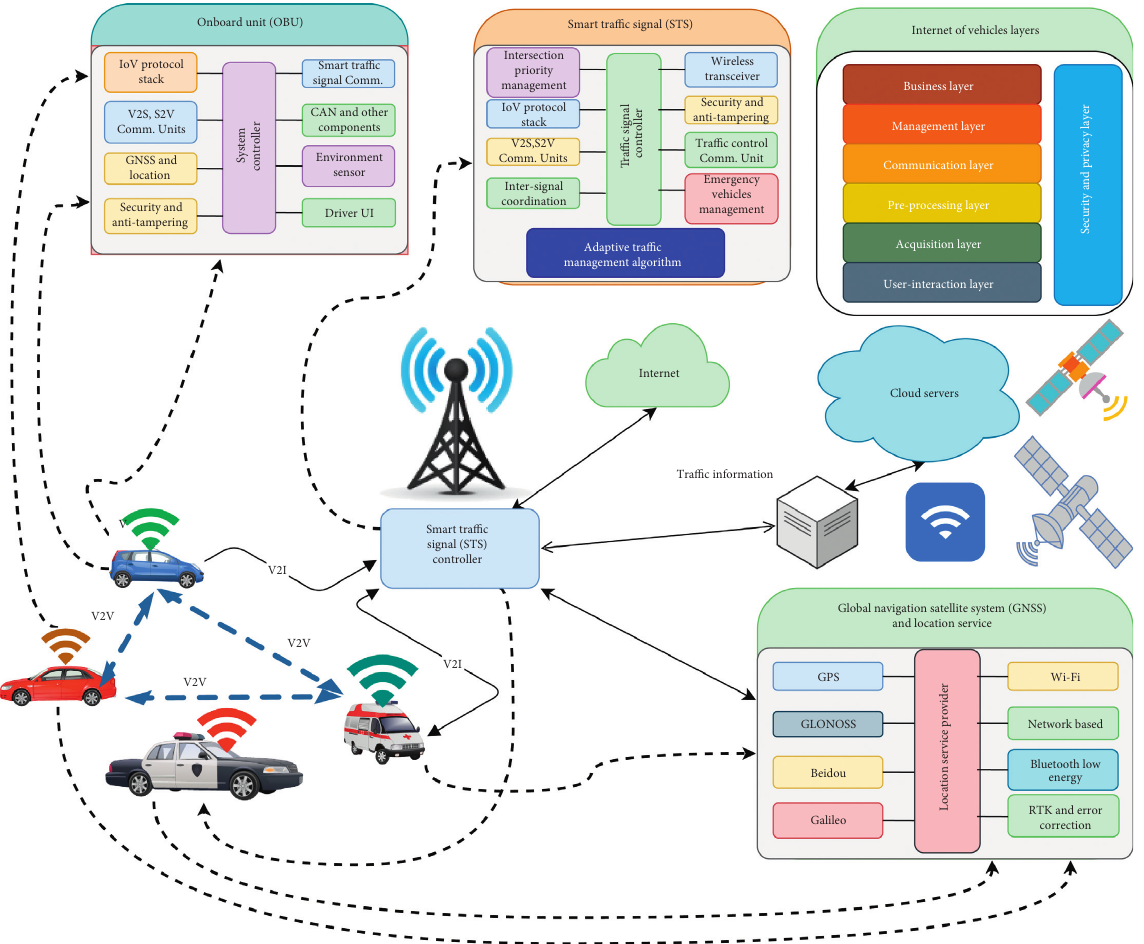
Figure 6: The architecture of the proposed ITMS based on IoV for Smart